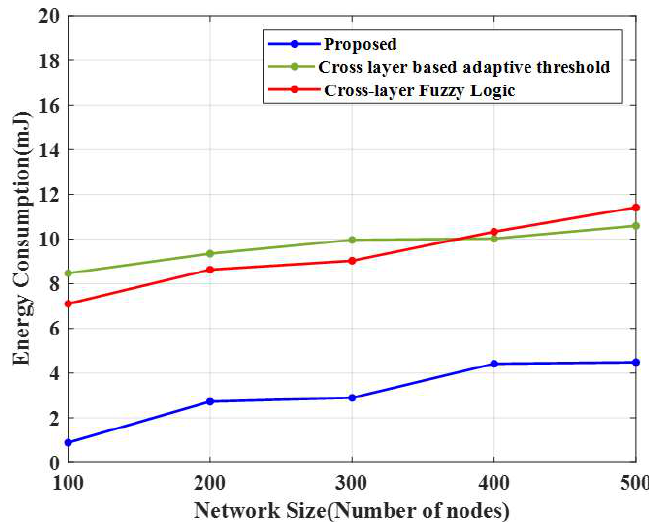
Figure 5. Energy consumption comparison.